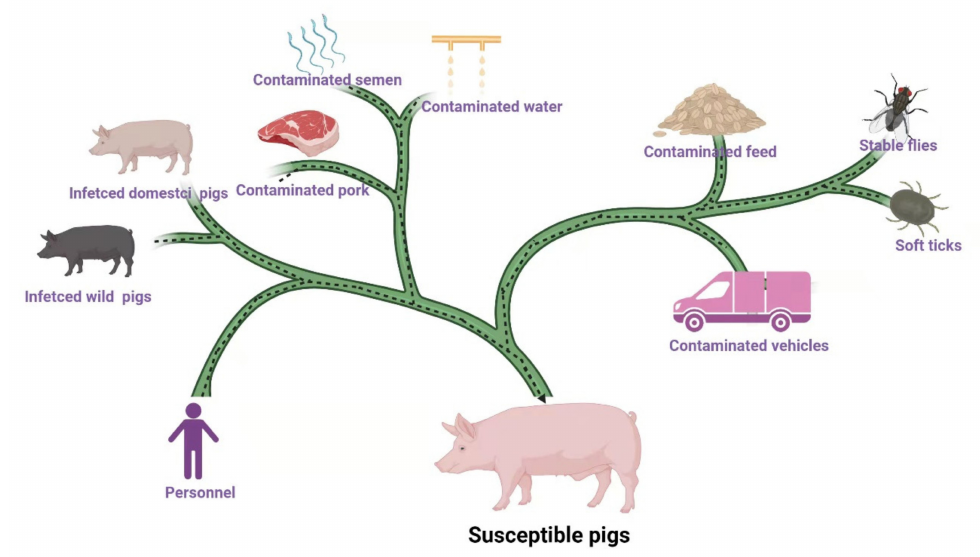
Figure 1. The source of ASFV infection. Infected domestic pigs, wild pigs, soft ticks, contaminated feed, water, semen, pork, personnel, vehicles, and tools are the main sources of ASFV. Stable flies and other insects (leeches, kissing bugs, and swine lice) may spread ASFV. Epidemiological survey showed infected domestic pigs and wild pigs and contaminated feed, personnel, vehicles, and pork are the main sources of infection in China [11,17]. (Copyright agreement number is LR23BRLD53). Infectious sources carry viruses for a long time, which is one of the difficulties of preventing and controlling ASF. African warthogs, bush pigs, and soft ticks of Ornithodoros spp. are the reservoir hosts of ASFV [18,19]. O. marocanus carries the virus for 655 days or even 5 years, with other Ornithodoros ticks such as O. porcinus porcinus , maintaining an ASFV sylvatic cycle between desert warthogs ( Phacochoerus aethiopicus ) and soft ticks